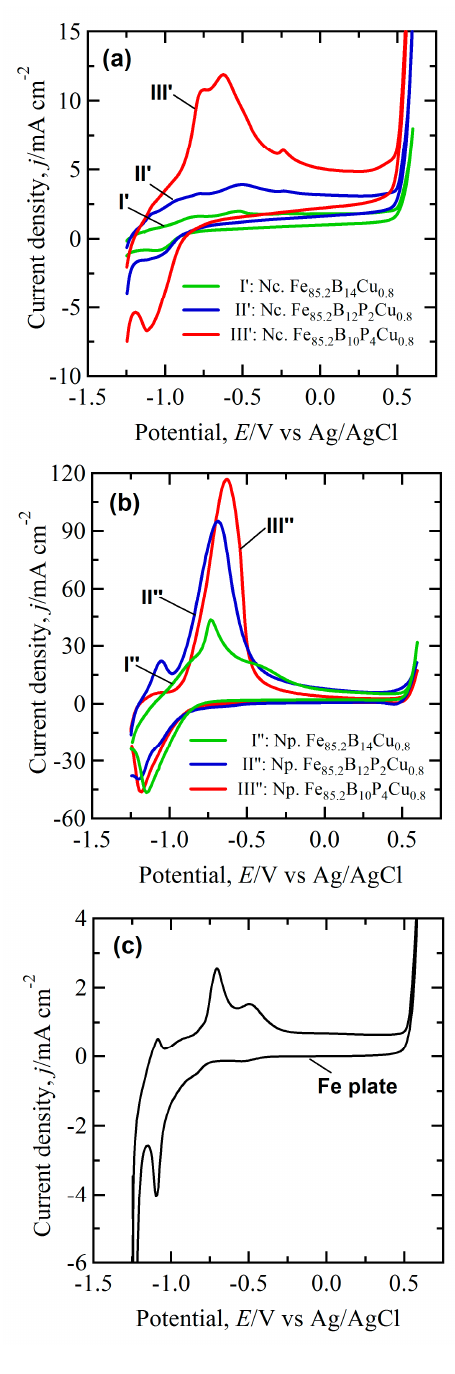
Figure 8. CV curves of nanocrystalline ( a ) nanoporous; ( b ) electrodes and pure Fe plate; ( c ) in 6.0 M KOH solution. Scan rate: 50 mV/s. Nanocrystalline electrodes: Fe 85.2 B 14 Cu 0.8 (I ′ ), Fe 85.2 B 12 P 2 Cu 0.8 (II ′ ) and Fe 85.2 B 10 P 4 Cu 0.8 (III ′ ) alloys after annealing of amorphous precursor alloys. Nanoporous electrodes: Fe 85.2 B 14 Cu 0.8 (I ′′ ), Fe 85.2 B 12 P 2 Cu 0.8 (II ′′ ) and Fe 85.2 B 10 P 4 Cu 0.8 (III ′′ ) alloys after dealloying of nanocrystalline precursor alloys in 0.1 M H 2 SO 4 solution for 7.2 ks.